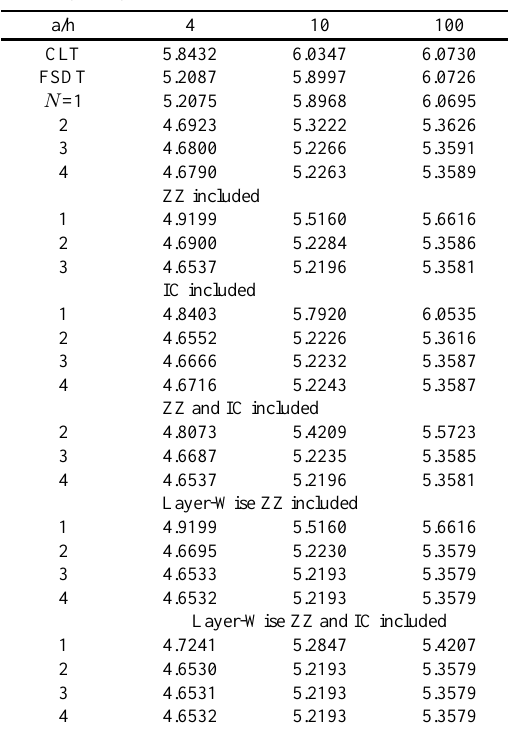
(cid:2) 2 ρ 1 h E 1